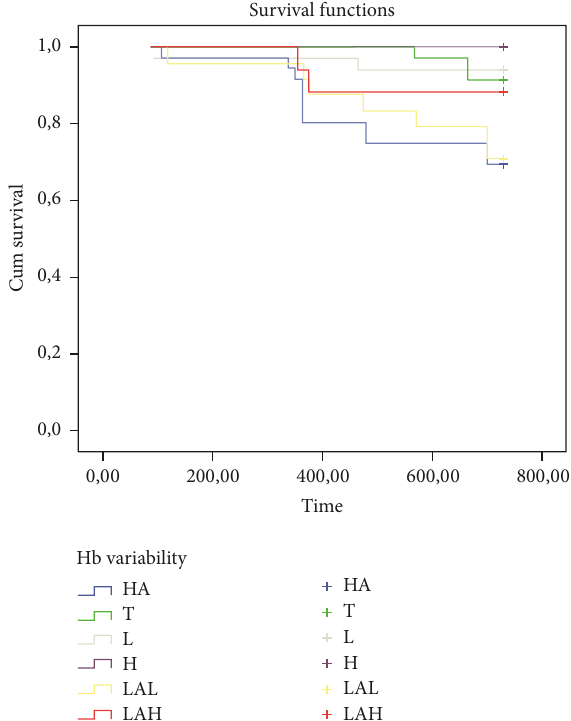
Figure 1: Kaplan–Meier analysis showing significant difference associated with mortality in each of the hemoglobin variability groups. Consistently high (H), consistently low (L), consistently within the target range (T) groups showed survival advantage compared with low-amplitude fluctuation with high hemoglobin levels (LAH), low-amplitude fluctuation with low hemoglobin levels (LAL), and high-amplitude fluctuation (HA) groups (100%, 94.1%, 91.4%, 88%, 70.8%, and 69.4%, resp.; 𝑝 < 0.009 ).